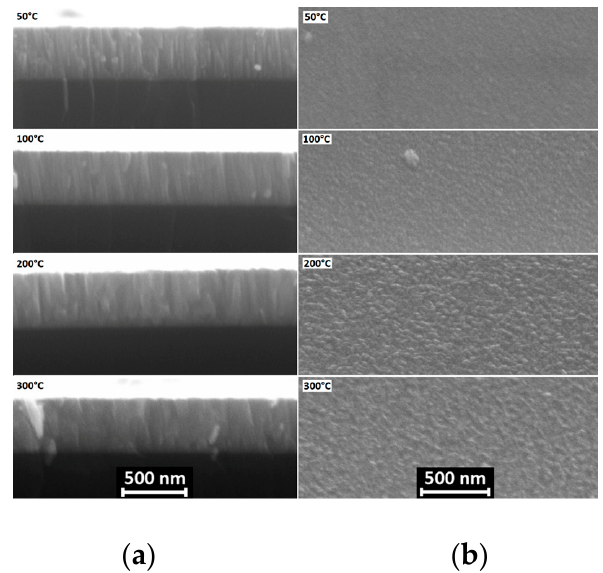
Figure 2. ( a ) Cross-section morphologies of the indium–tin oxide (ITO) thin films; ( b ) Surface morphologies of the ITO thin films. Substrate temperature shown in the insets.